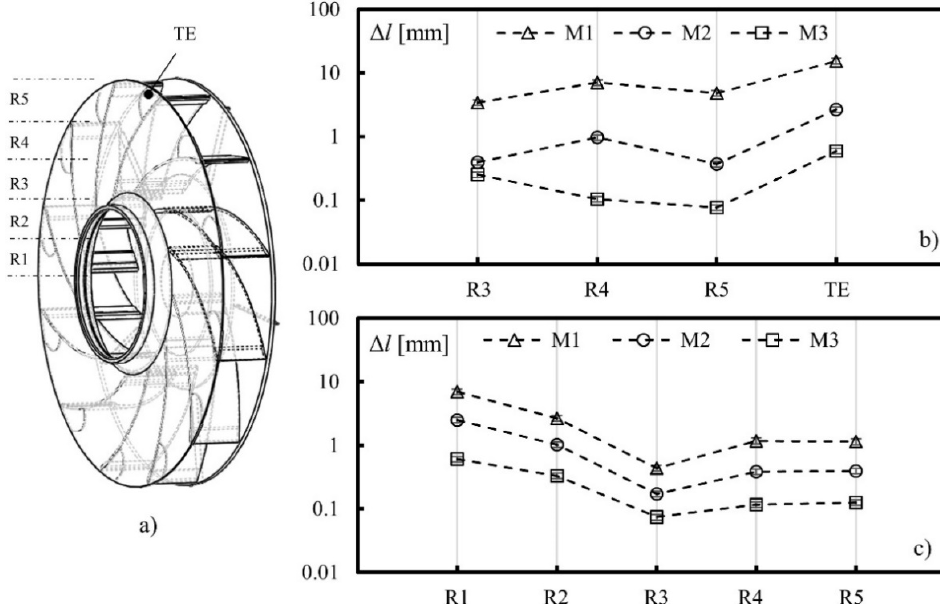
Figure 5. Rotor wear: ( a ) patches coordinates and material loss, ( b ) on the shroud, and ( c ) on the hub. R1, R2, R3, R4 and R5 are the radial annular areas, TE is the trailing edge.